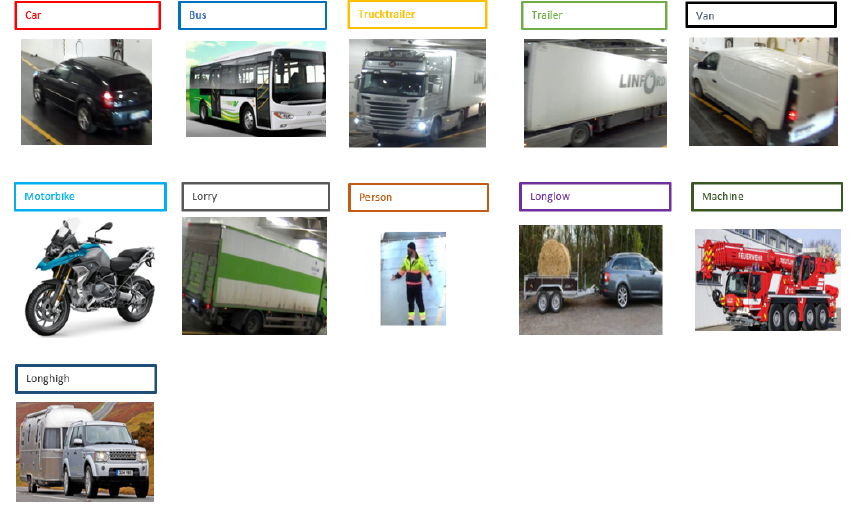
Figure 1. Sample of objects, including a person class, to be detected in the ROROGREEN and SCDS projects. There are eleven images and each corresponds to the respective target